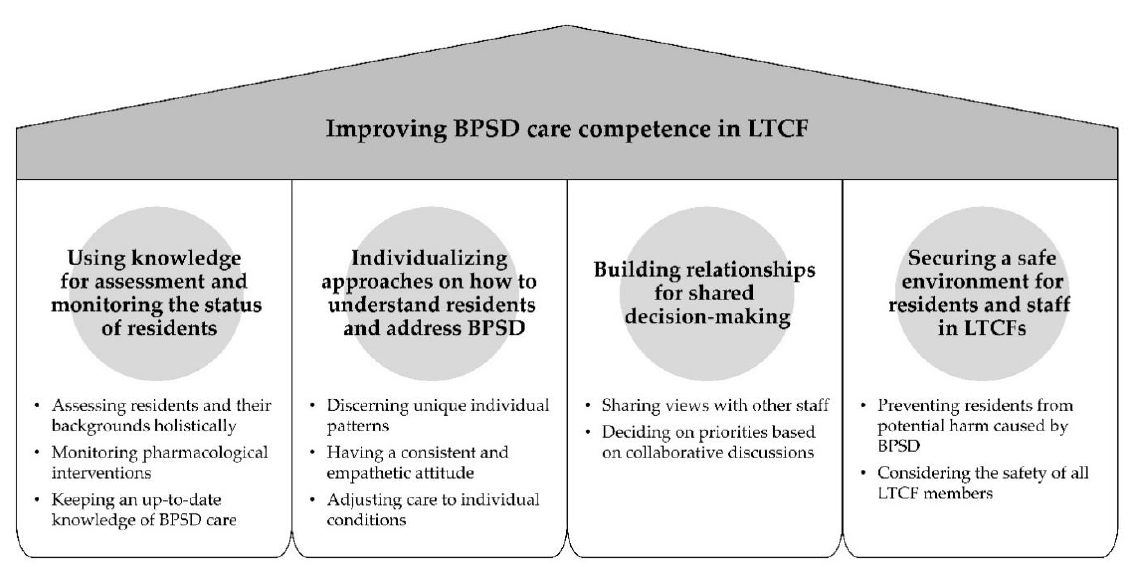
Figure 4. A preliminary educational framework to improve BPSD care competence in LTCF.